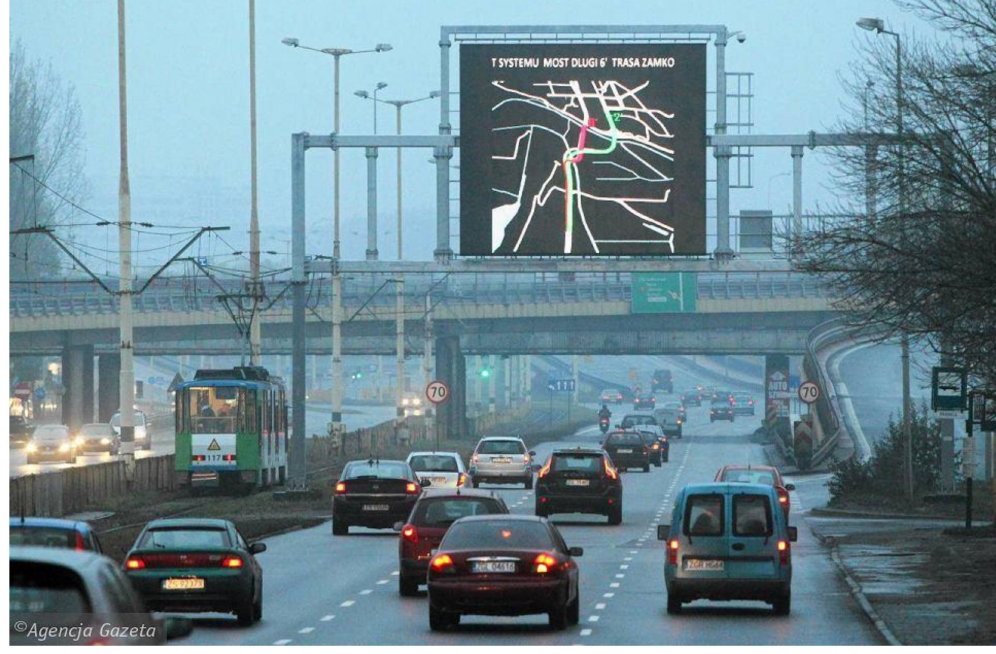
Figure 4. A variable message board.